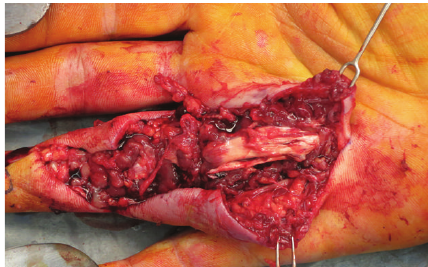
Figure 3: Debridement and radical synovectomy of his flexor ten- don sheath secondary to necrotizing soft tissue infection. Erythema and induration surrounded the open wound, as well as nonviable wound edges that failed to bleed with manipulation, raising concern for a necrotizing soft tissue infection. He was immediately taken for surgical debridement and radical synovectomy of the right ring finger flexor tendon sheath, and tissue from the tendon sheath was sent for routine and mycobacterial cultures. Intravenous clarithromycin and moxifloxacin were initiated to empirically cover any potential superinfection. Twenty-four hours after admission, he was discharged to complete a six-month course of oral moxifloxacin and clarithromycin. AFB cultures were retuned positive, consistent with persistent Mycobacterium marinum.